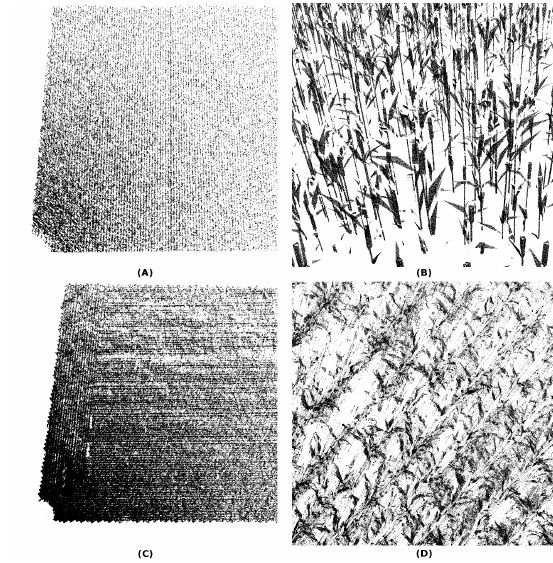
Figure 7: A procedurally generated crop field point cloud (overview A and close-up B) compared to a real one (overview C and close-up